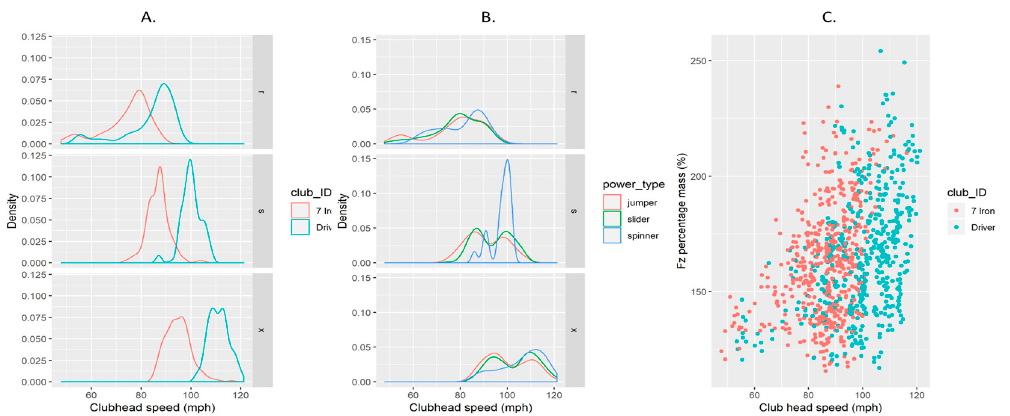
Figure 3. ( A ) Density plot all the golfers by clubhead speed against the club flex for both driver and 7-iron. ( B ) Separating each shaft group into different force productions differentiated by club (color) and faceted by the shaft flex. ( C ) Adding every shot clubhead speed as a scatter plot with percentage mass. S.